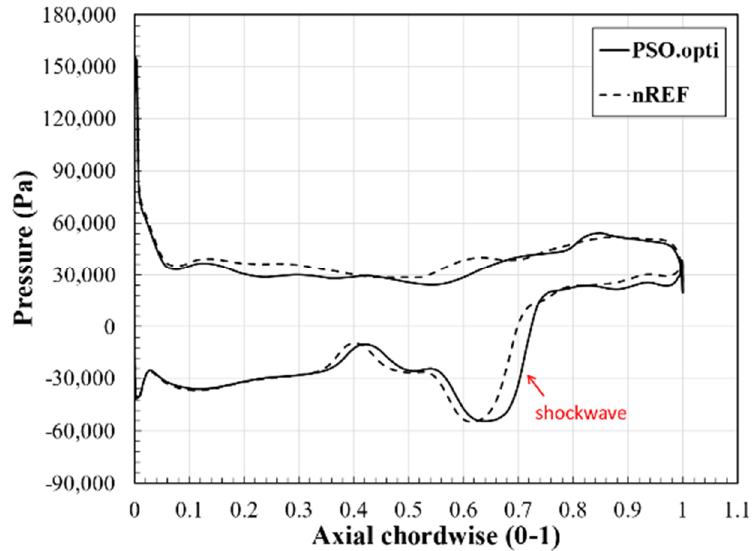
Figure 17. Blade loading at 99% rotor span at peak adiabatic efficiency condition.